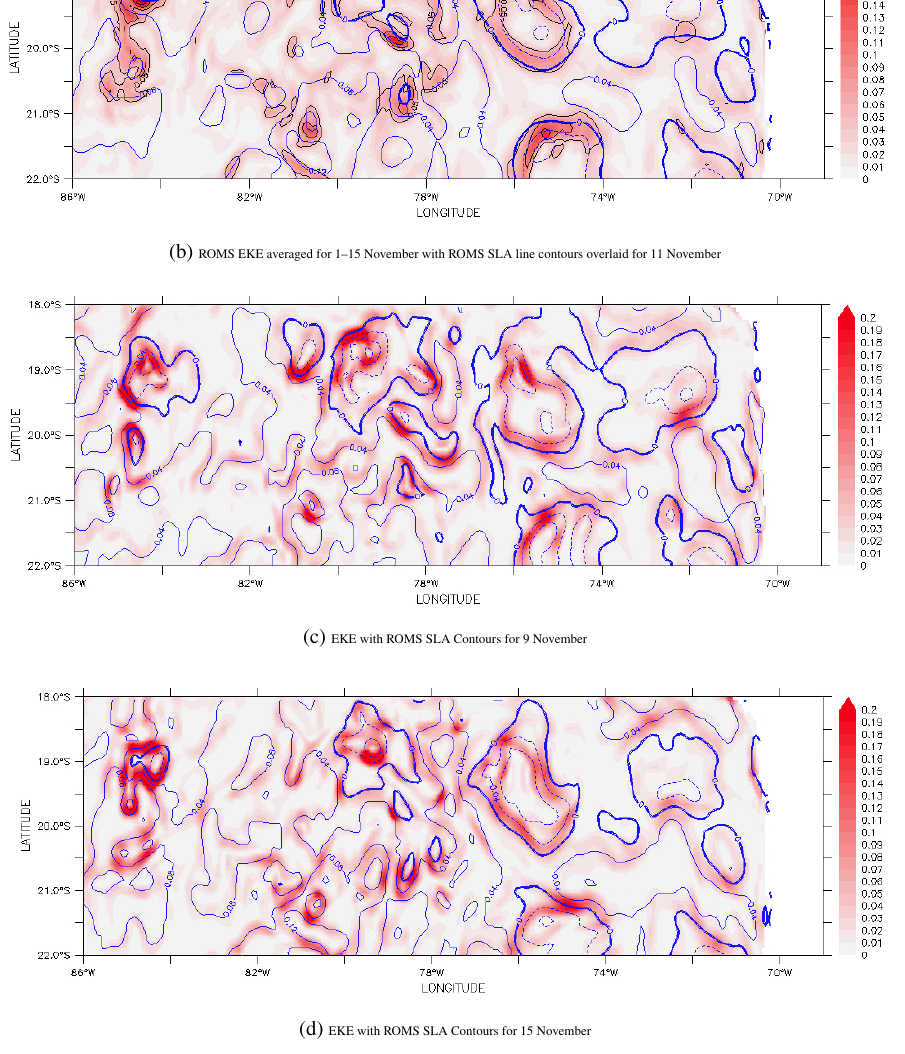
Fig. 12. Eddy Kinetic Energy (EKE) averaged for the first two weeks of November from the model overlaid on the (a) AVISO SLA and (b) ROMS SLA. EKE are daily averaged for (c) 9 November and (d) 15 November.